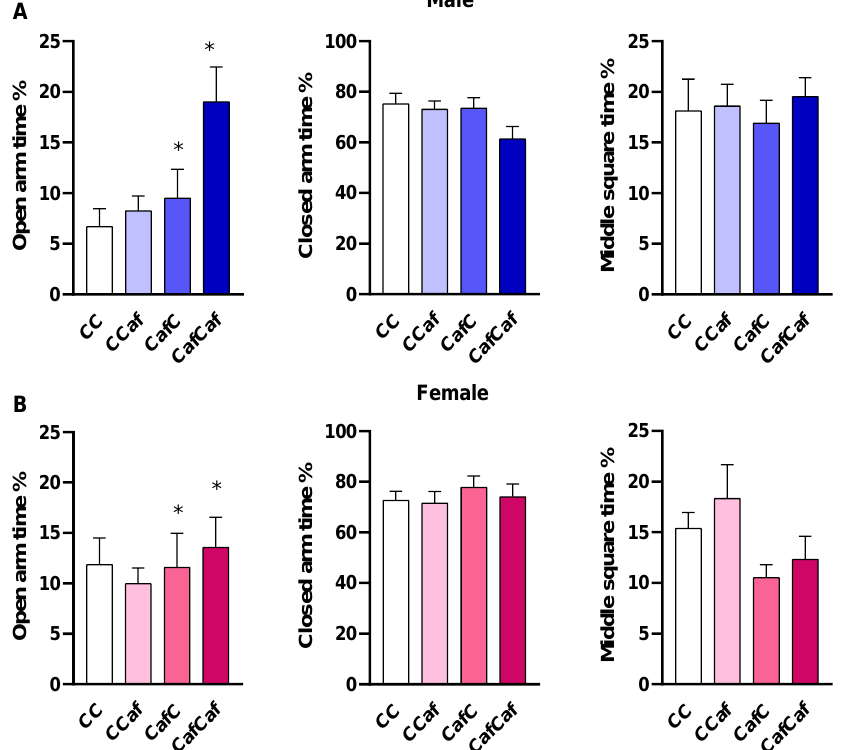
Figure 7. Fasting blood glucose concentration ( A ), body fat % ( B ) and lean mass ( C ) of male and female offspring at seven weeks of age. ChowChow (11 male, 11 female), ChowCaf (11 male, 11 female), CafChow (13 male, 11 female), and CafCaf (13 male, 13 female); C depicts chow. Data are expressed as mean ± SEM and were analysed by three-way ANOVA. ** p < 0.01 significant effect of maternal Caf diet, †† p < 0.01 significant effect of offspring post weaning diet. Elevated Plus Maze (EPM) Behaviour Percent time in the open arms of the maze was significantly increased by maternal exposure to Caf diet (F = 5.84, p = 0.018) with no other significant effects of postweaning diet (F = 2.18, p = 0.14), sex (F < 1), or any interactions (all p > 0.05; Figure 8).